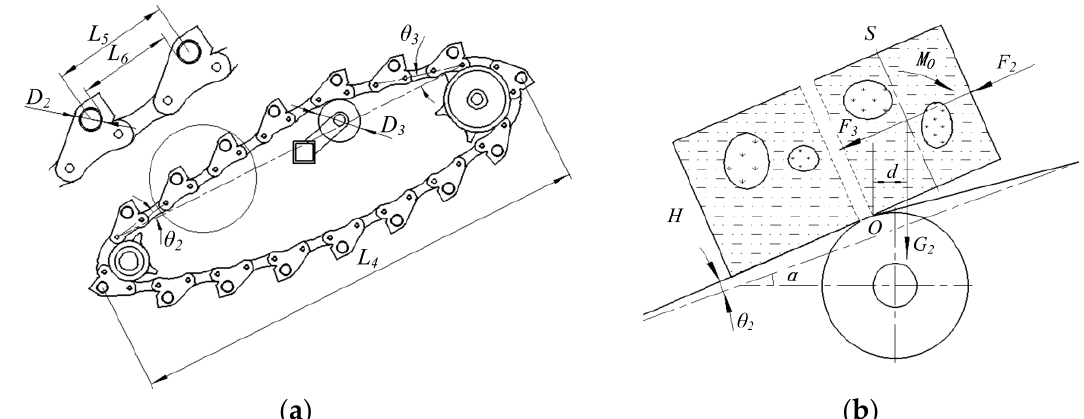
Figure 4. ( a ) Structural parameters of the first-stage lifting chain; ( b ) the force analyses of potato-soil mixture during the bending area.